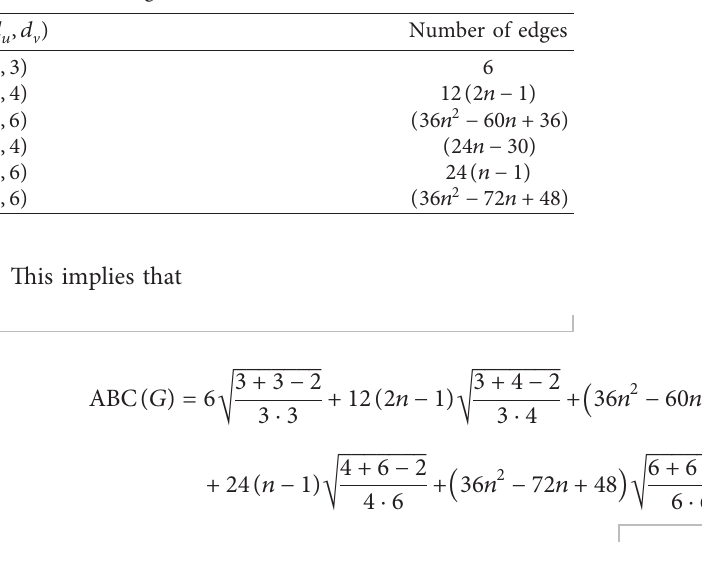
Figure 4: The graph of star of silicate network SSL ( 2 ) . Table 5: Edge partition of SSL ( n ) centred on the degree of the end vertices of each edge, where uv ∈ E ( G )